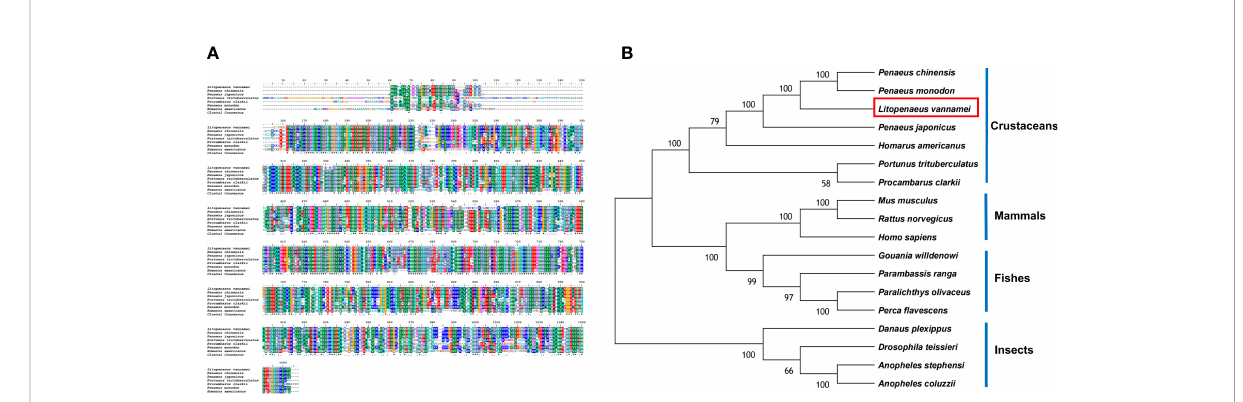
FIGURE 3 (A) Multiple alignments of deduced amino acids of LV-APN protein and its homologs. Species names are listed on the left side. (B) The phylogenetic tree shows relationships between the APN protein of L. vannamei (red rectangle) and those of other organisms. Species names are listed to the right of the tree.